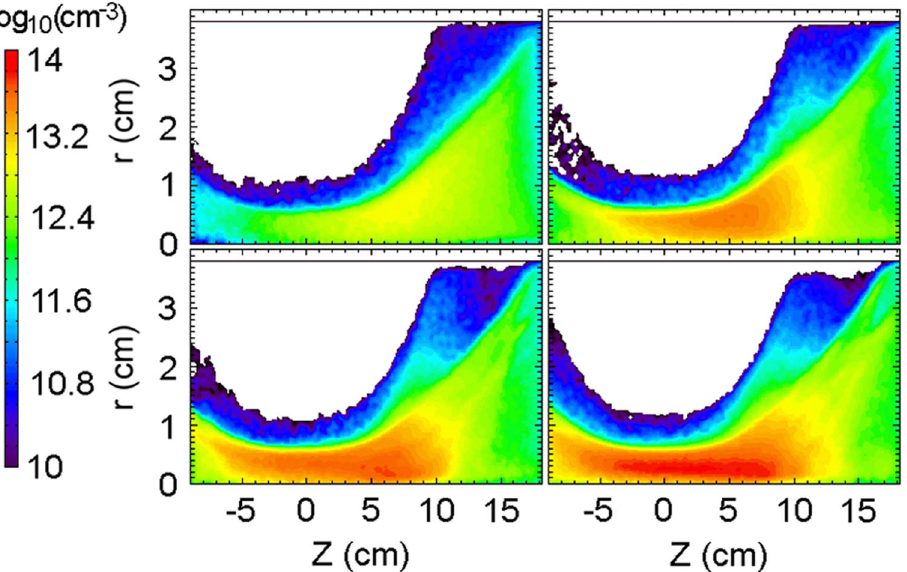
(cid:6) 40 kG solenoid, for initial ion injection z